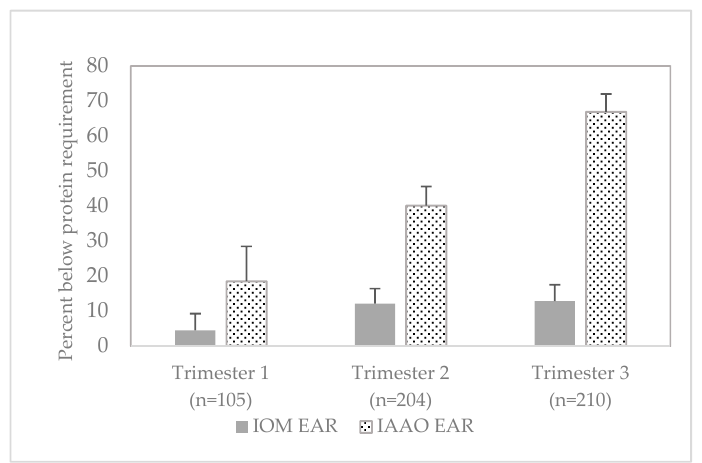
Figure 1. Percent of pregnant women ages 20–44 years with protein intake below reference require- ments, 2003–2012 National Health and Nutrition Examination Survey. Values presented as mean per- cent (± SE). Protein requirements-IOM EAR: 0.66 g/kg bw/day for trimester 1, 0.88 g/kg bw/day for trimesters 2 and 3 [3]; IAAO EAR: 0.93 g/kg bw/day for trimester 1, 1.22 g/kg bw/day for trimester 2, 1.52 g/kg bw/day for trimesters 3 [6,7]. Abbreviations: EAR—estimated average requirement, IAAO— indicator amino acid oxidation, IOM—Institute of Medicine.